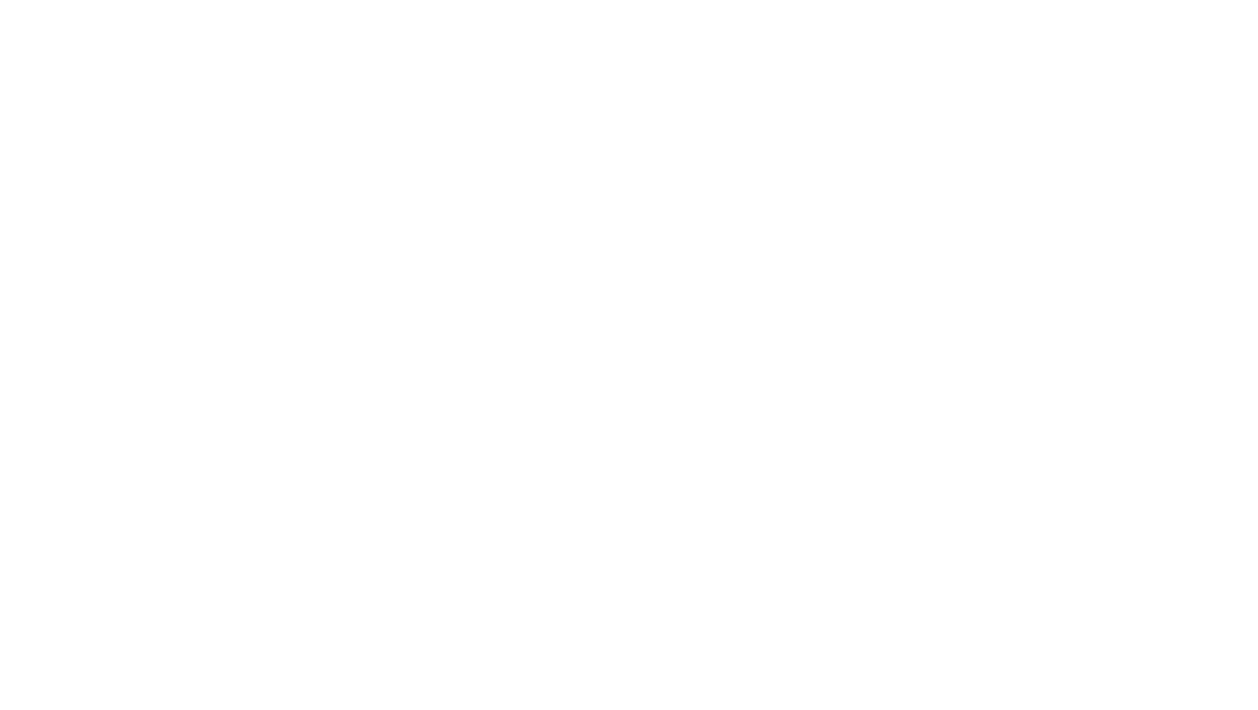
Frontiers in Pharmacology |